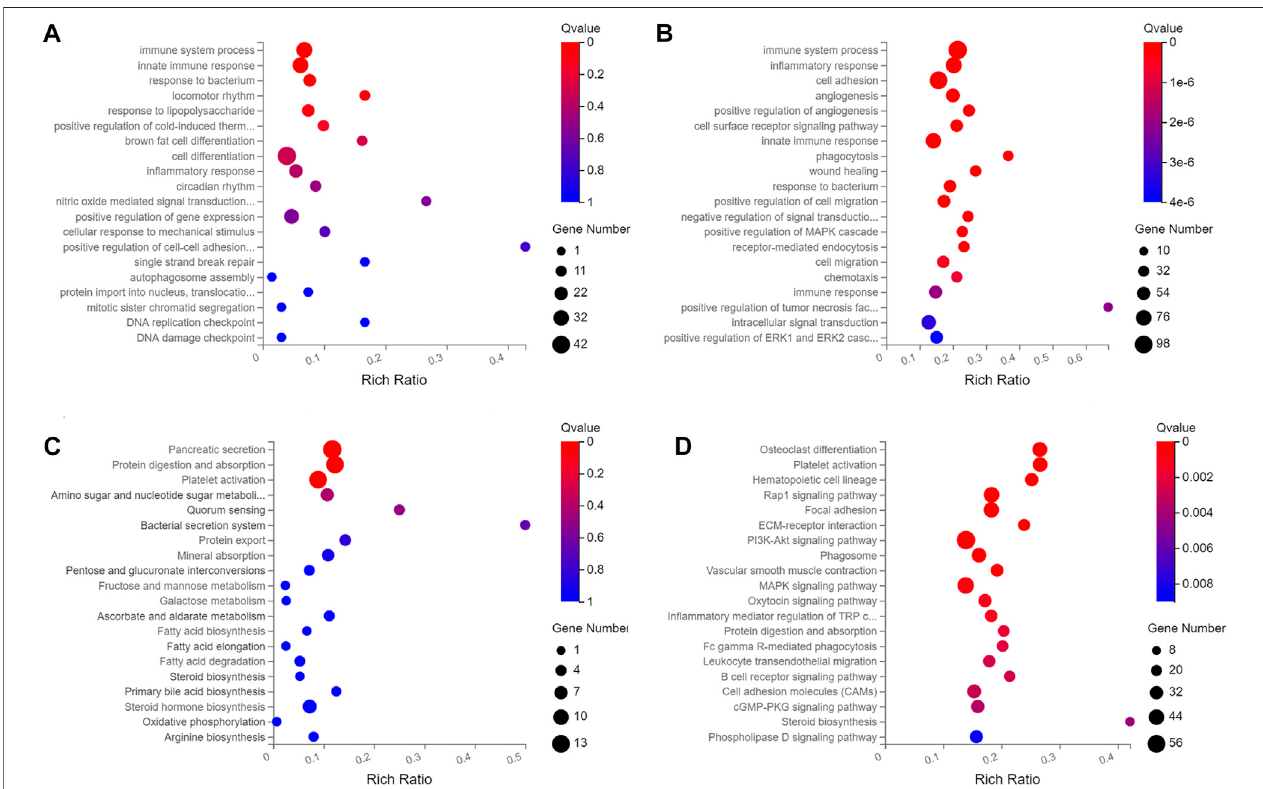
FIGURE 2 | The top twenty enriched biological process and pathways of DElncRNAs and DEmRNAs in HCs at 2 m p.i. and 3 m p.i.. (A) Predicted biological process terms of DElncRNAs and DEmRNAs in HCs at 2 m p.i.. (B) Predicted biological process terms of DElncRNAs and DEmRNAs in HCs at 3 m p.i.. (C) Predicted pathways of DElncRNAs and DEmRNAs in HCs at 2 m p.i.. (D) Predicted pathways of DElncRNAs and DEmRNAs in HCs at 3 m p.i..